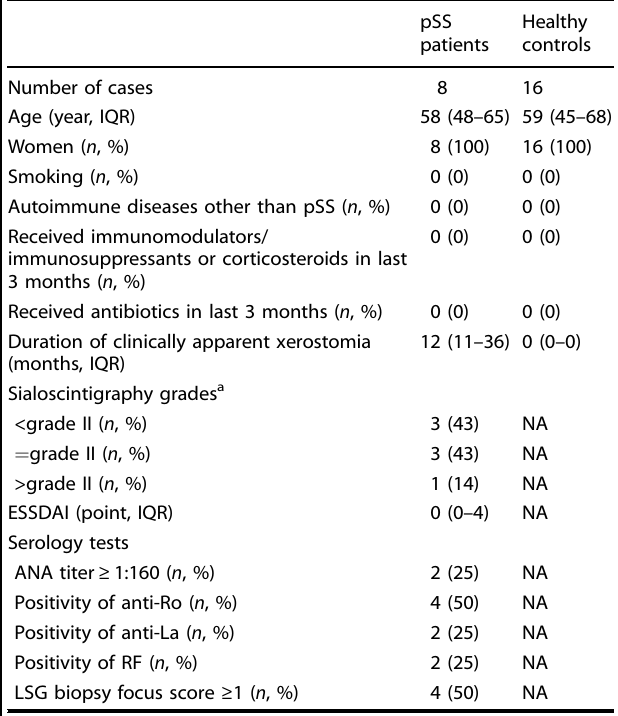
Table 1. Baseline characteristics of the study participants.